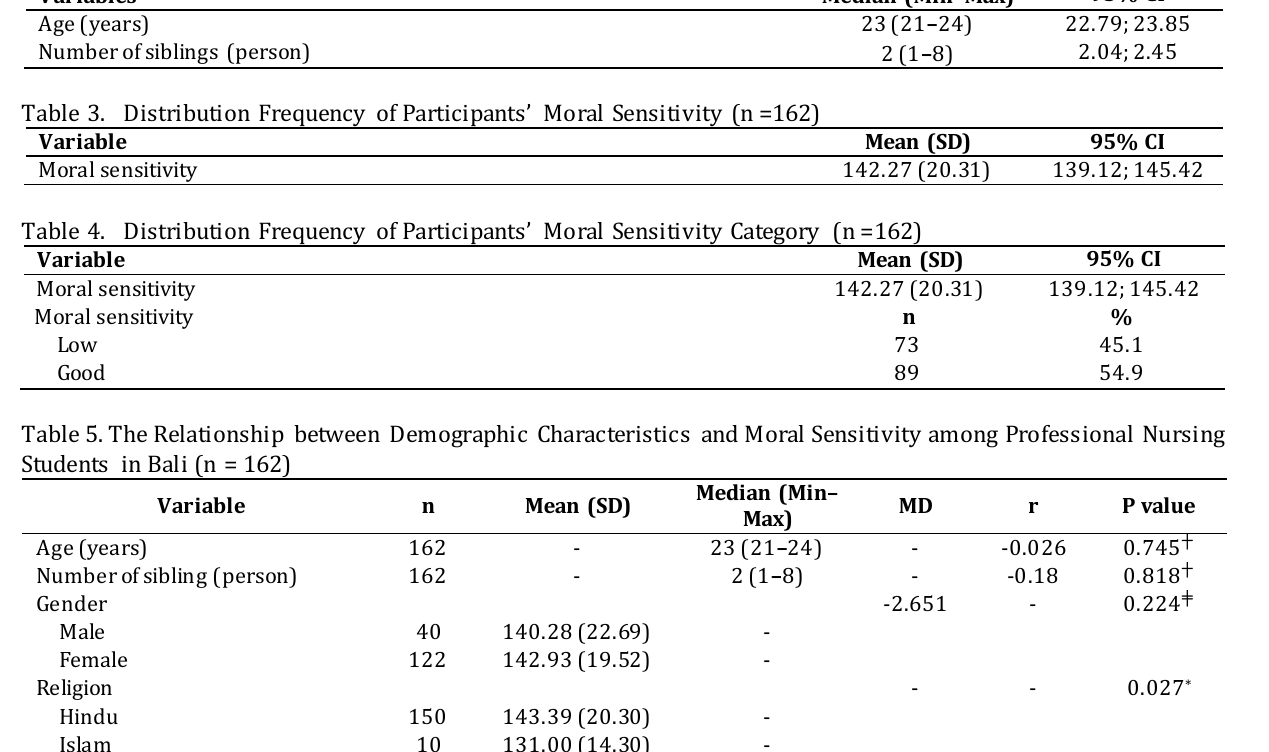
Table 2. Distribution Frequency of Age and Number of Siblings (n = 162) Variables